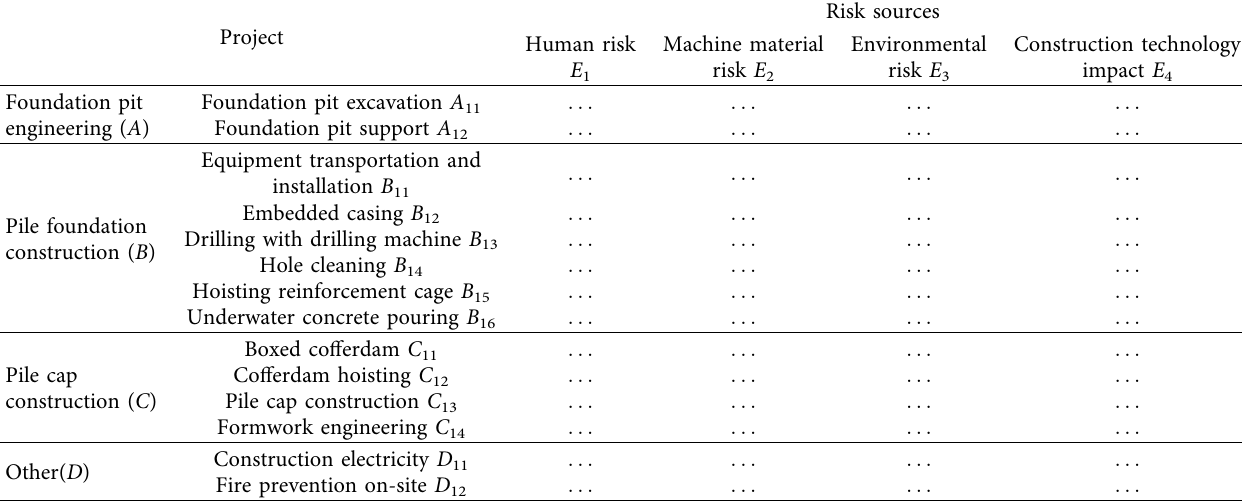
Table 6: Risk source identification table established using the WBS-RBS method.